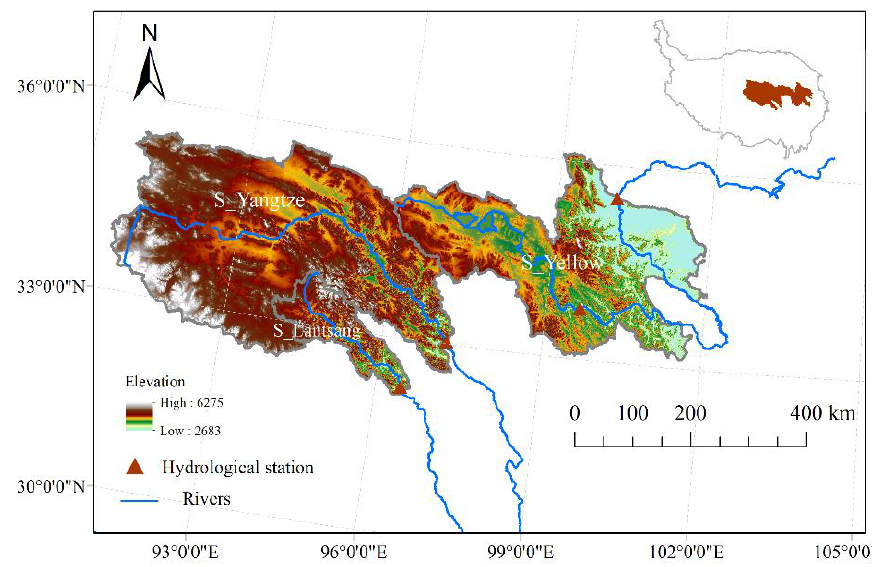
Figure 1. Location of the 5 hydrological stations across TRHR. 152